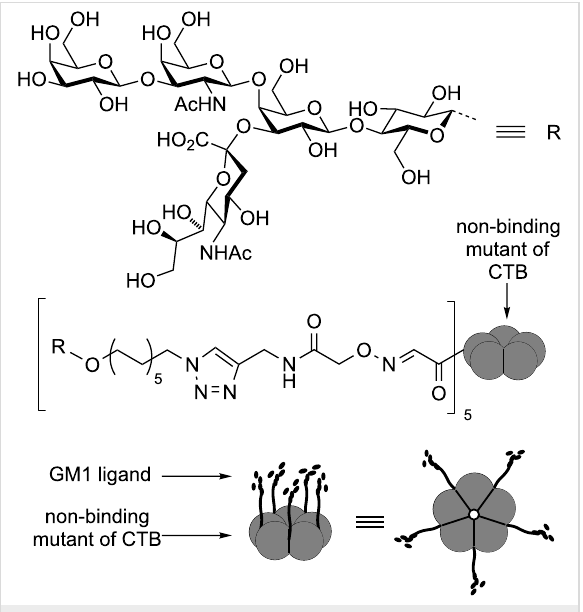
Figure 15: Neoglycoprotein inhibitor based on a non-binding mutant of